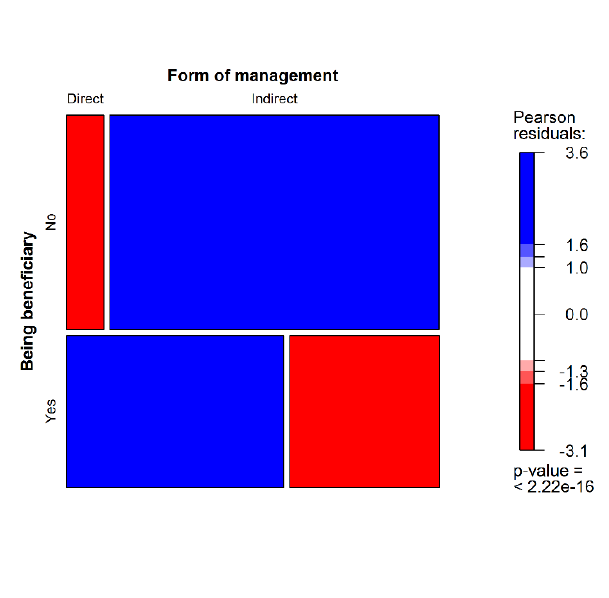
Figure A5.3. Mosaic plot of the frequency of being/not being beneficiary of ES depending on different form of ES management implemented (Direct/Indirect management). Each box is associated with a binary variable in left list (Yes beneficiary, and No beneficiary) and form of management in top list (Direct and Indirect forms of management). The height of a box is proportional to the number of observations for being/not being beneficiary of ES. The width of a box is proportional to the number of stakeholders implementing direct and indirect